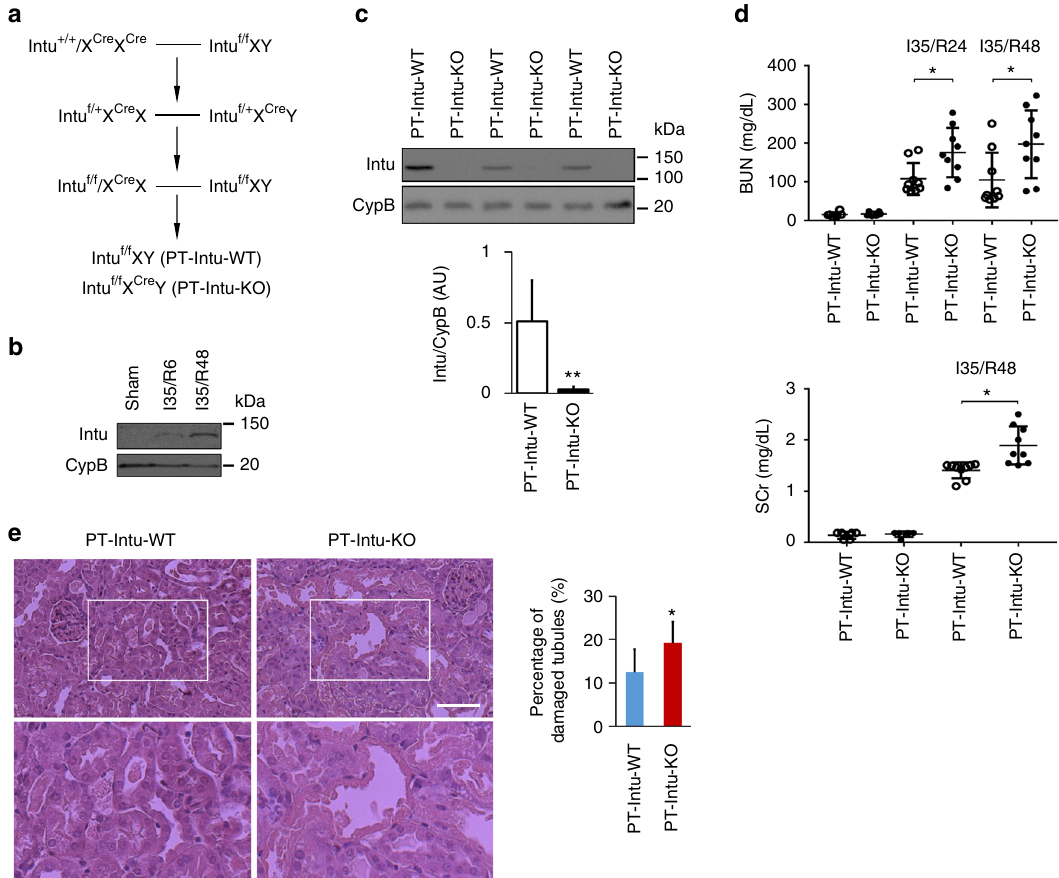
Fig. 1 Knockout of Intu from kidney proximal tubular cells aggravates renal IRI in mice. a Breeding protocol for generating PT-Intu-KO mouse model. b Induction of Intu in mouse kidneys by 35 min of bilateral renal ischemia with 6 or 48 h of reperfusion. c Intu expression at renal IRI (48 h) was abolished in PT-Intu-KO mice as compared to PT-Intu-WT mice ( n = 3). d PT-Intu-KO mice and PT-Intu-WT mice had similarly low levels of BUN and SCr under control condition ( n = 9), but renal IRI induced higher BUN and SCr in PT-Intu-KO mice ( n = 9). e Renal IRI induced more severe renal tubular damage in PT-Intu-KO mice than in PT-Intu-WT mice as shown by representative histology and quanti fi cation of the percentage of damaged tubules ( n = 6). Quantitative data are mean ± s.d. (error bars). Paired or grouped t test was used. * p < 0.05, ** p < 0.01. Scale bar: 100 µ m. AU arbitrary